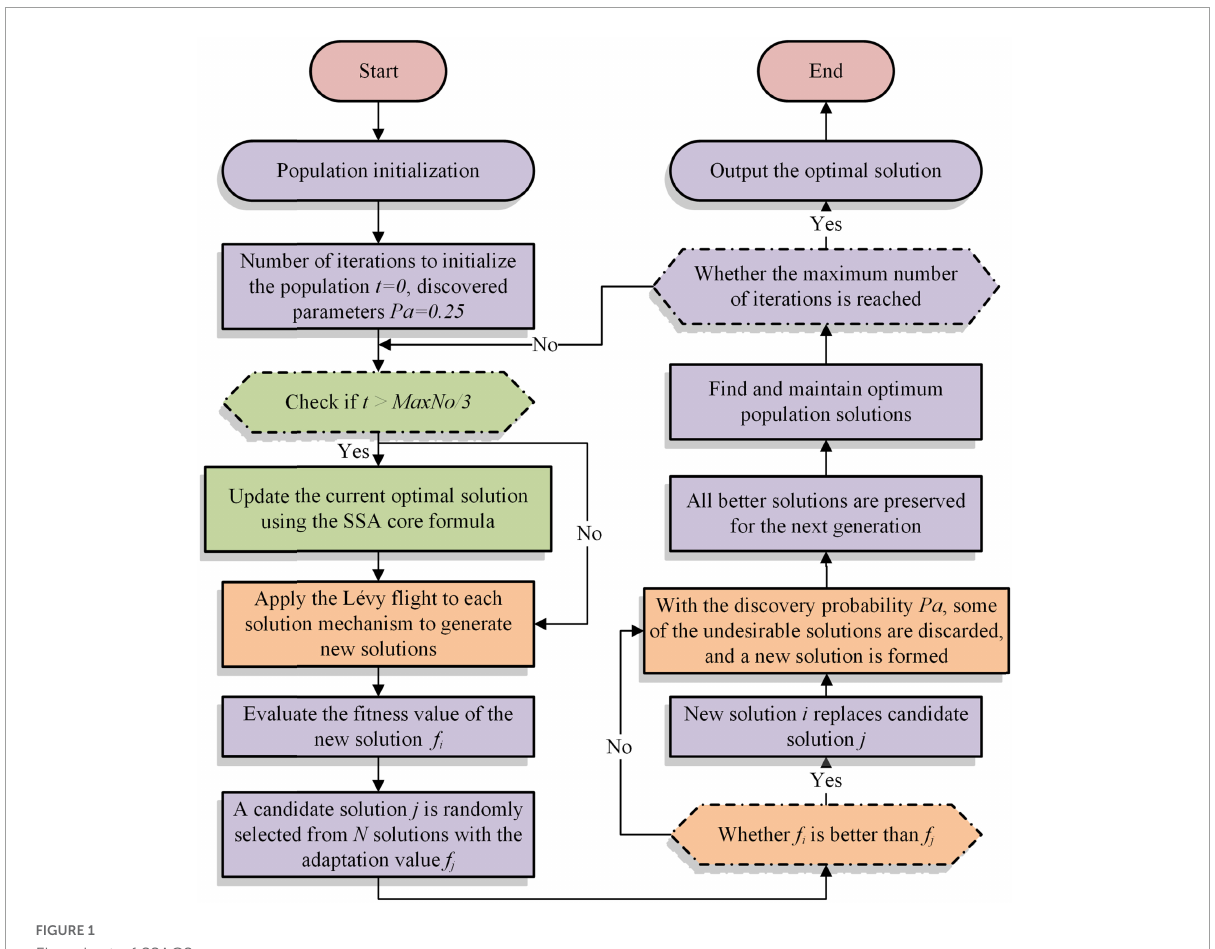
FIGURE1 Flowchart of